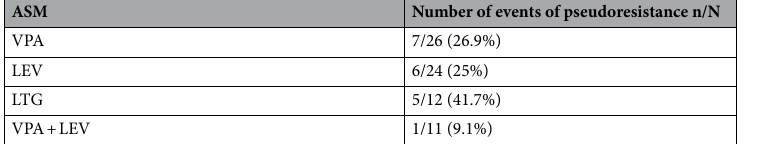
Table 3. Pseudoresistance effects: ASM use. ASM antiseizure medication, n number of pseudoresistance events, N number of patients on the